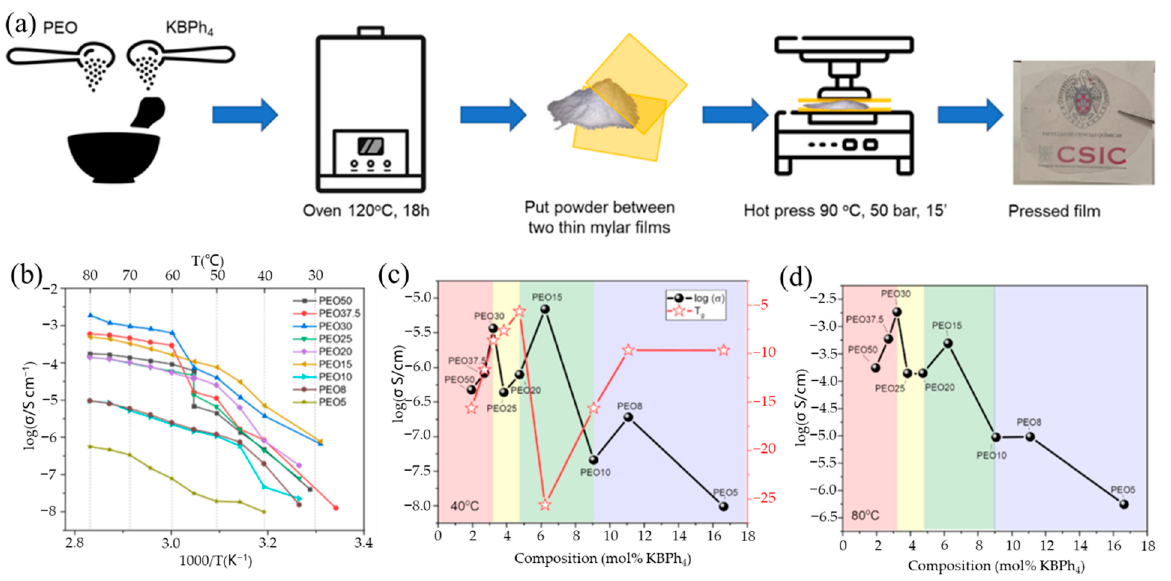
Figure 8. ( a ) Schematic sequence of the synthesis route of PEO/KBPh4 electrolyte films by hot pressing. ( b ) Arrhenius plots for all of the polymer/salt composite electrolytes. ( c , d ) Isotherms of ionic conductivity vs. mole fraction of KBPh 4 in the polymer electrolyte at ( c ) below (40 °C) and ( d ) above (80 °C) the melting point of crystalline PEO. T g values are plotted in the secondary y-axis of ( c ). ( a – d ) Reproduced with permission from Ref. [91]. Copyright 2022 American Chemical Society.